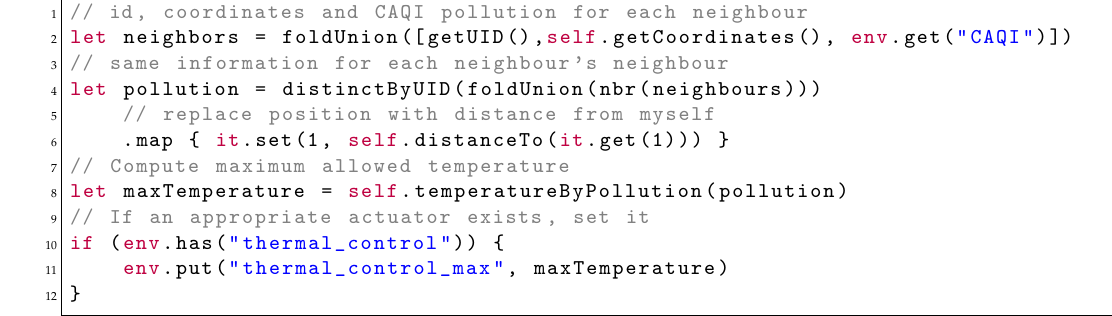
Figure 8. Protelis code for the case study